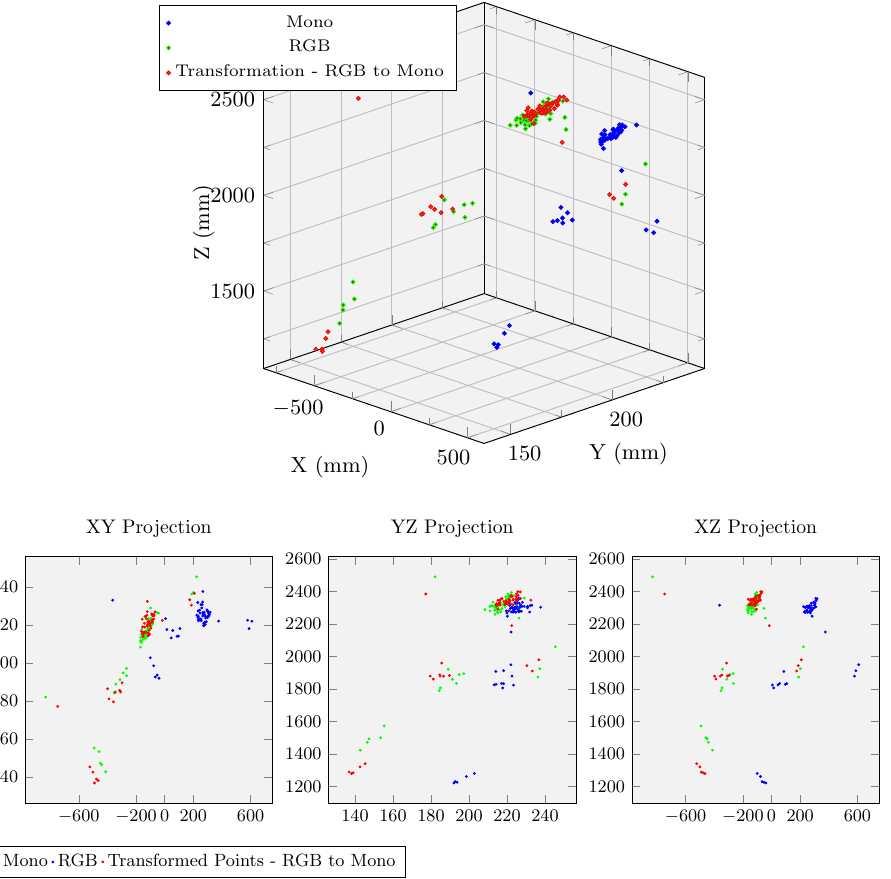
Figure 8. Illustration of the results of calibrating a RGB and Mono camera. Through the registration procedure, green points are transformed into red points which match closely the blue point